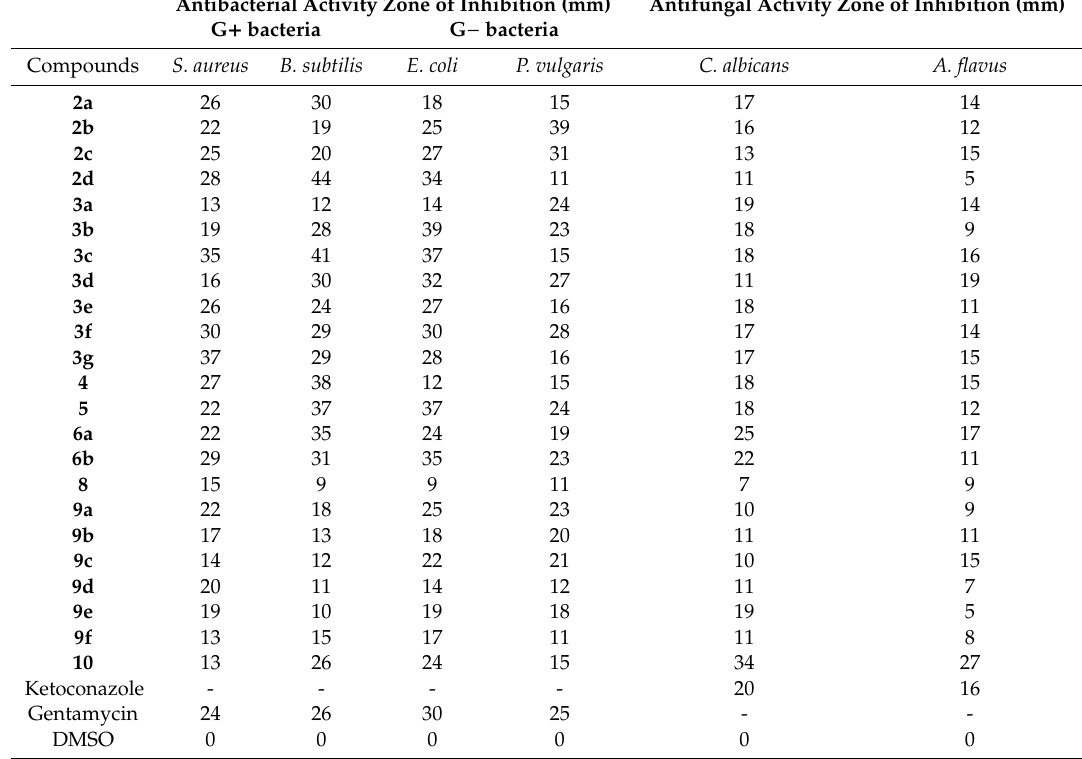
Table 1. Antimicrobial activities of compounds 2–6 and 8–10